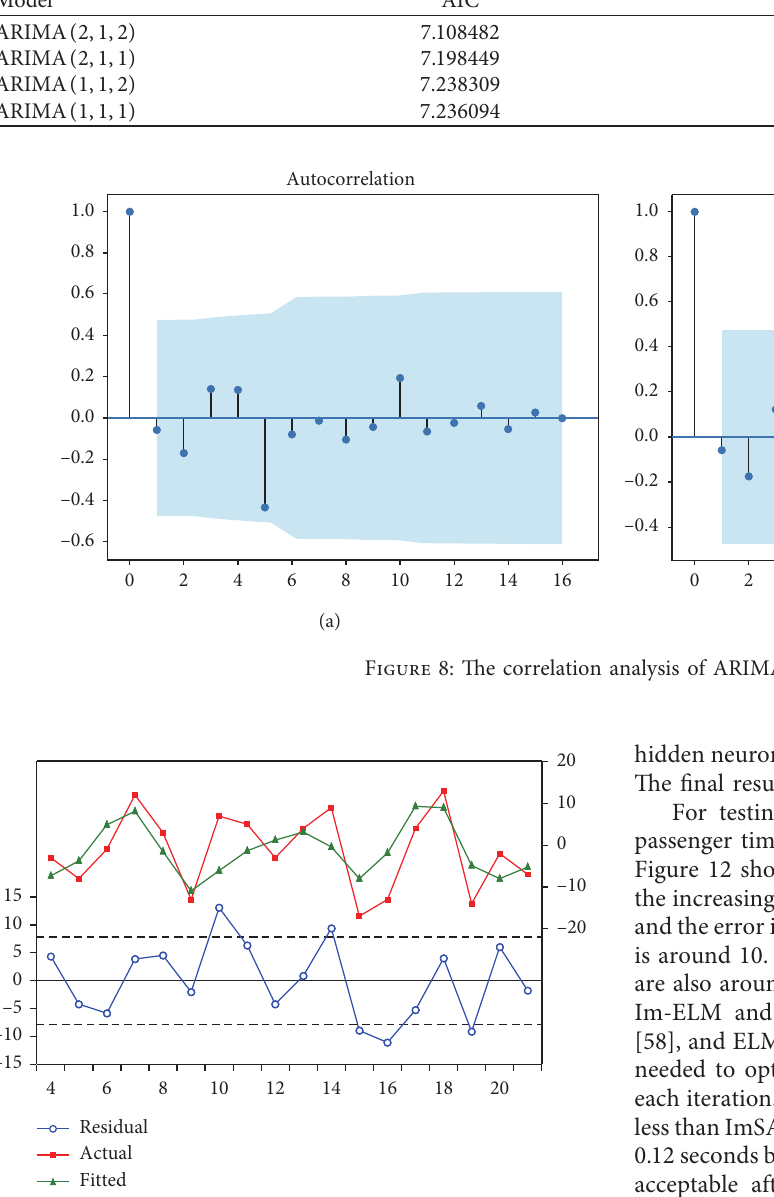
Figure 9: The fitting analysis of ARIMA ( 2 , 1 , 2 ) .